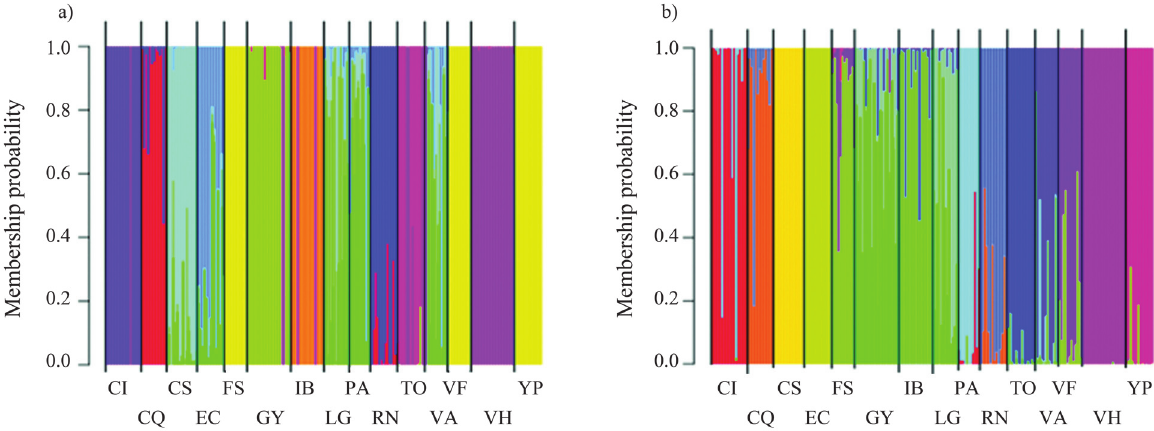
Figure 5 - STRUCTURE-like plot of DAPC analysis for a global picture of the clusters composition. Each individual is represented by a vertical colored line. Same color in different individuals indicates that they belong to the same cluster. a) K = 12, obtained with find.clusters option; b) K = 15, obtained with a priori information of sampling sites. Population Codes are given in Table